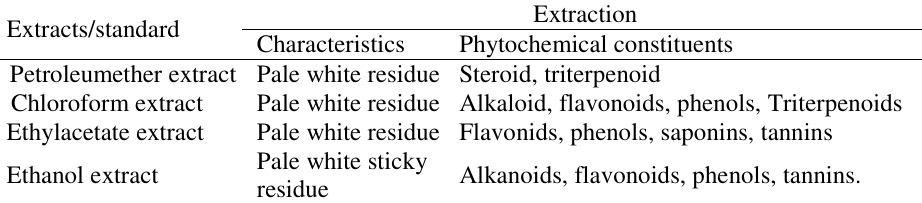
Table 1. Extraction, phytochemical analysis and in vitro antioxidant activity of Allium sativum L . from different places